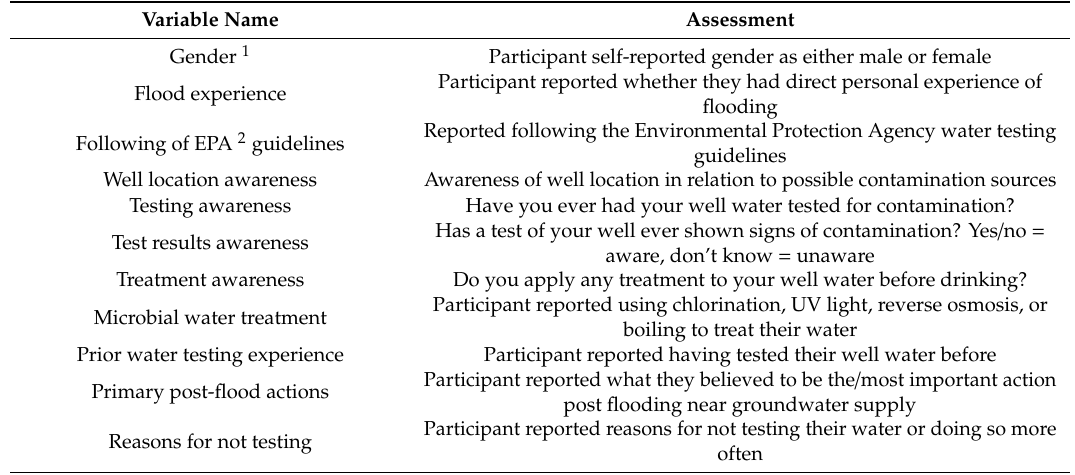
Table 2. Variables and their assessment in the